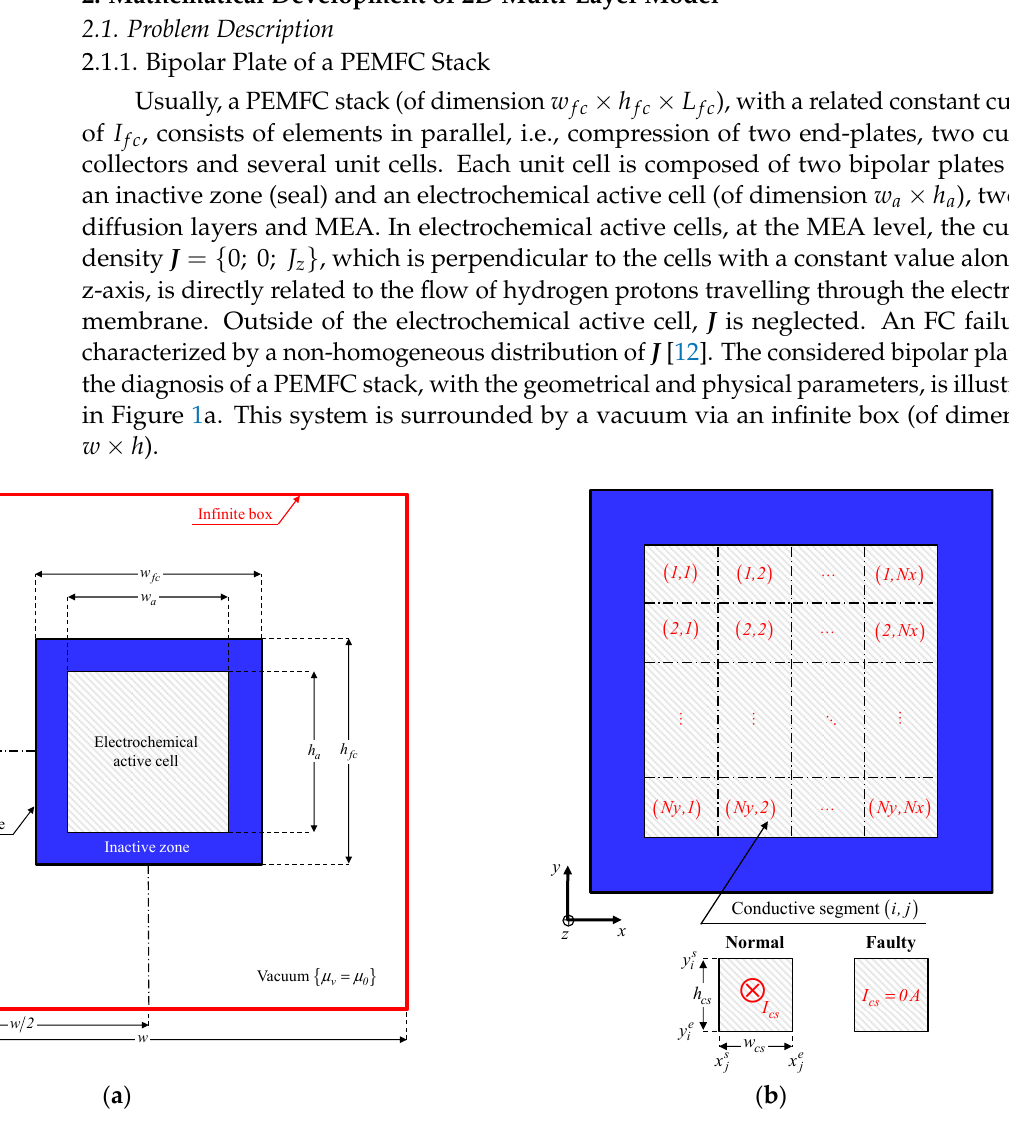
Figure 1. ( a ) Bipolar plate and ( b ) Electrochemical active cell modeled by Ny × Nx conductive segments for the diagnosis of a PEMFC stack (see Table 1 for the various parameters). Table 1. Geometrical and physical parameters of a PEMFC